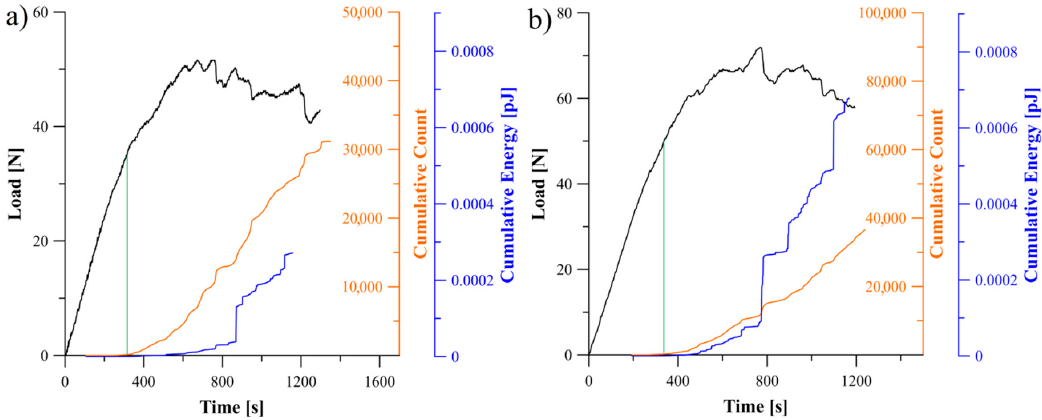
Figure 12. Relation between load, cumulative count and energy of AE signal obtained during the DCB experiment: ( a ) for specimen with 0 ◦ // 45 ◦ delamination interface, ( b ) for specimen with 0 ◦ // 60 ◦ delamination interface.